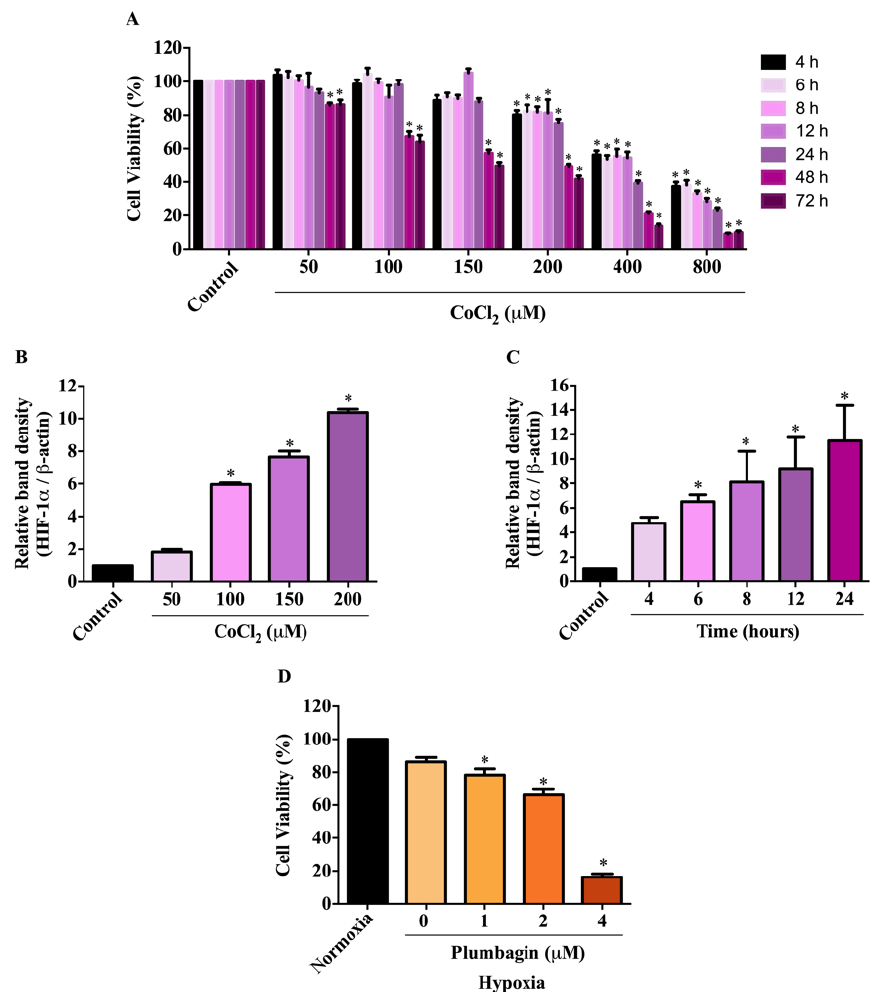
Figure 3. Effects of CoCl 2 -induced conditions on HIF-1 α expression and MCF-7 cell viability. ( A ) MCF-7 cells were treated with 0–800 µ M of CoCl 2 for 4, 6, 8, 12, 24, 48, and 72 h and